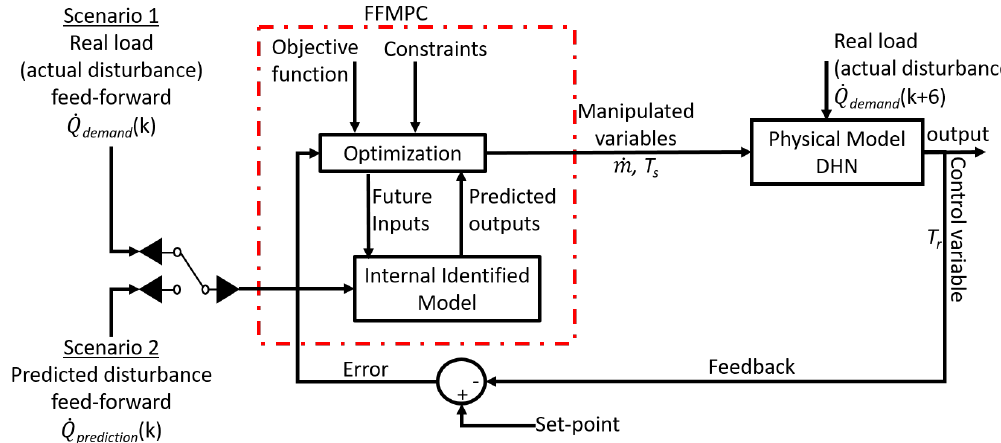
Figure 5. Overview of FFMPC implementation and feed-forward signal: Scenario 1—historical load and Scenario 2—prediction